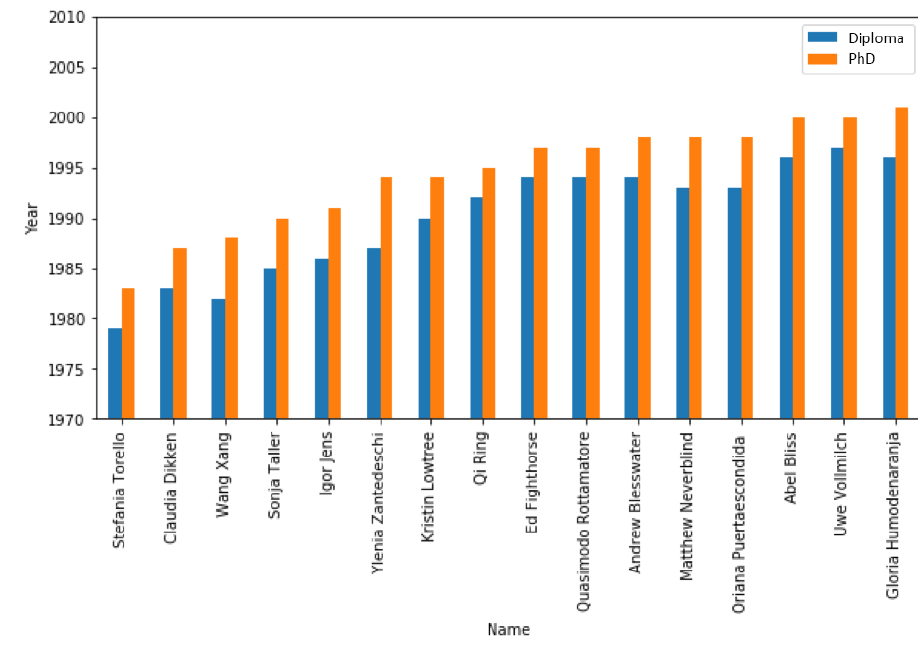
Figure 2. Bar chart of the years when each of the PIs get their Diploma and PhD sorted by the year of the PhD